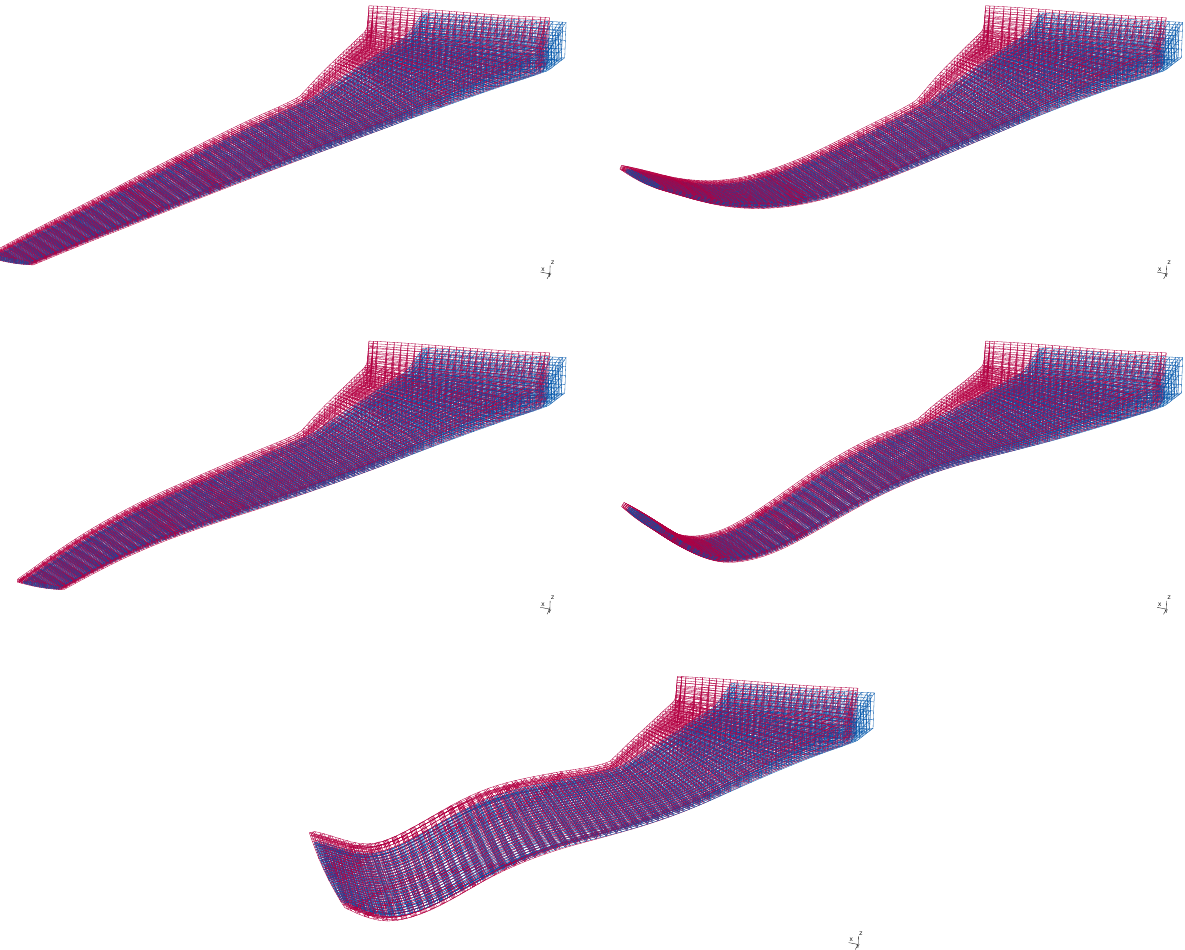
Fig. 7. First five natural vibration modes of the structure of the reference structure (blue) and their interpolation onto the structure mesh of the optimized planform